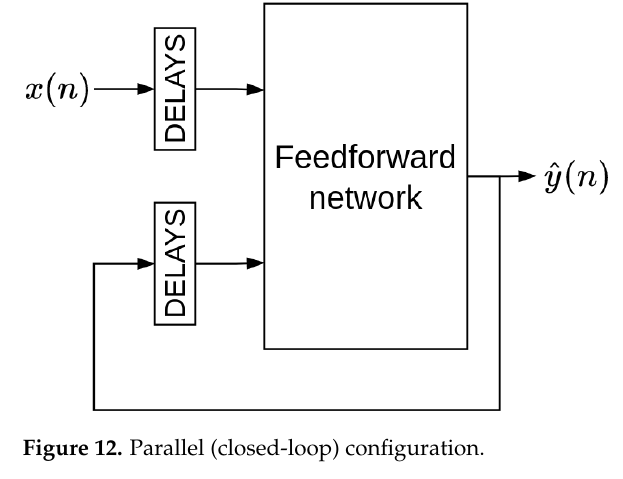
Figure 12. Parallel (closed-loop) configuration.